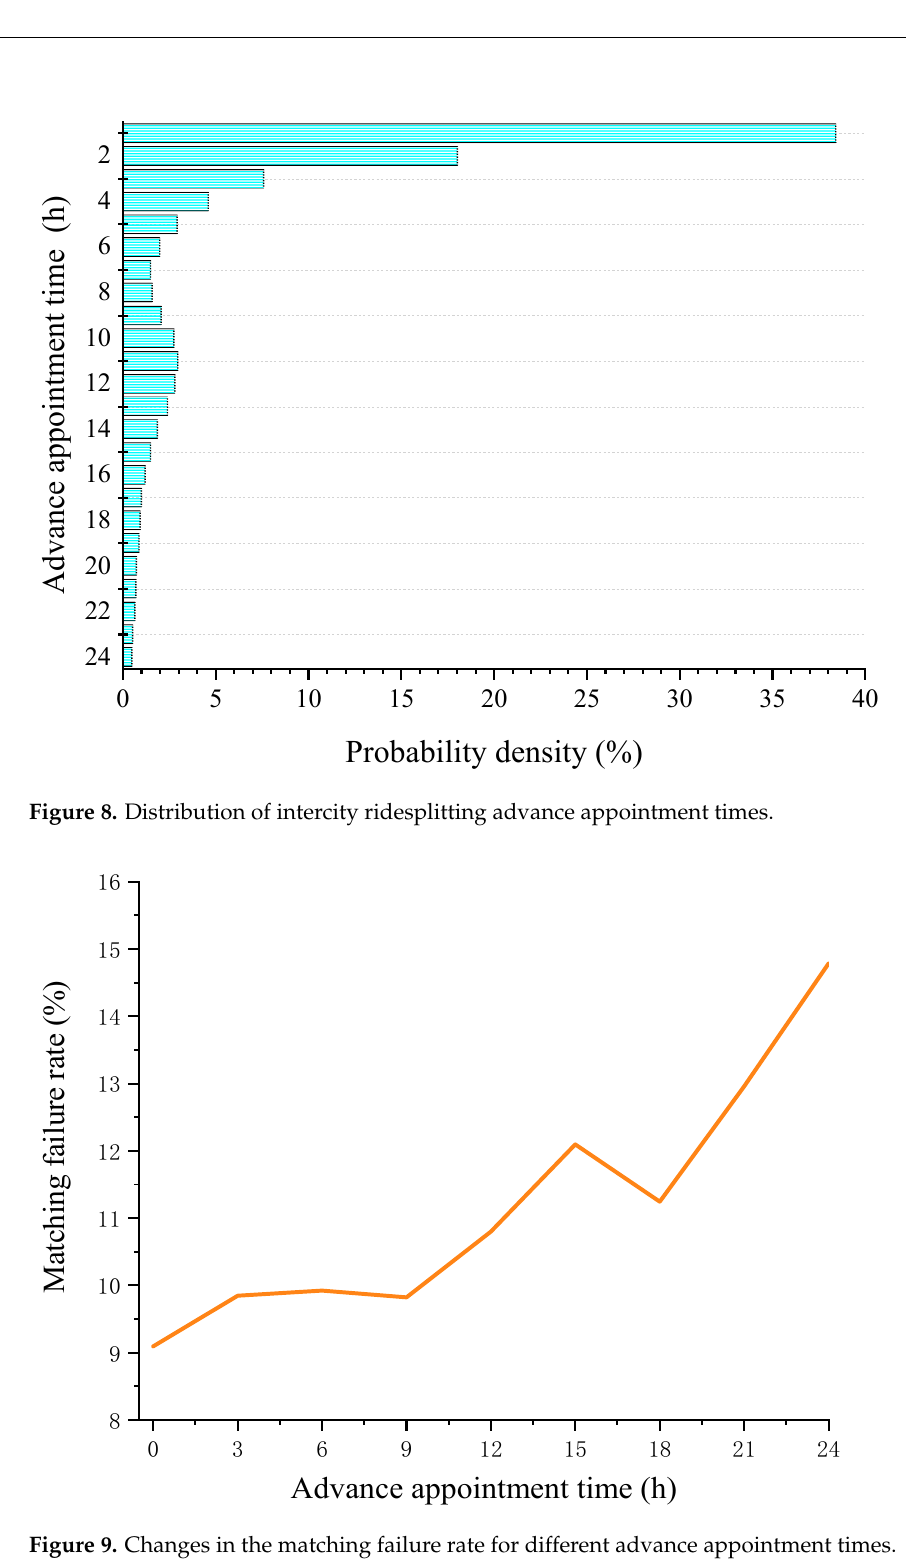
Figure 9. Changes in the matching failure rate for different advance appointment times.